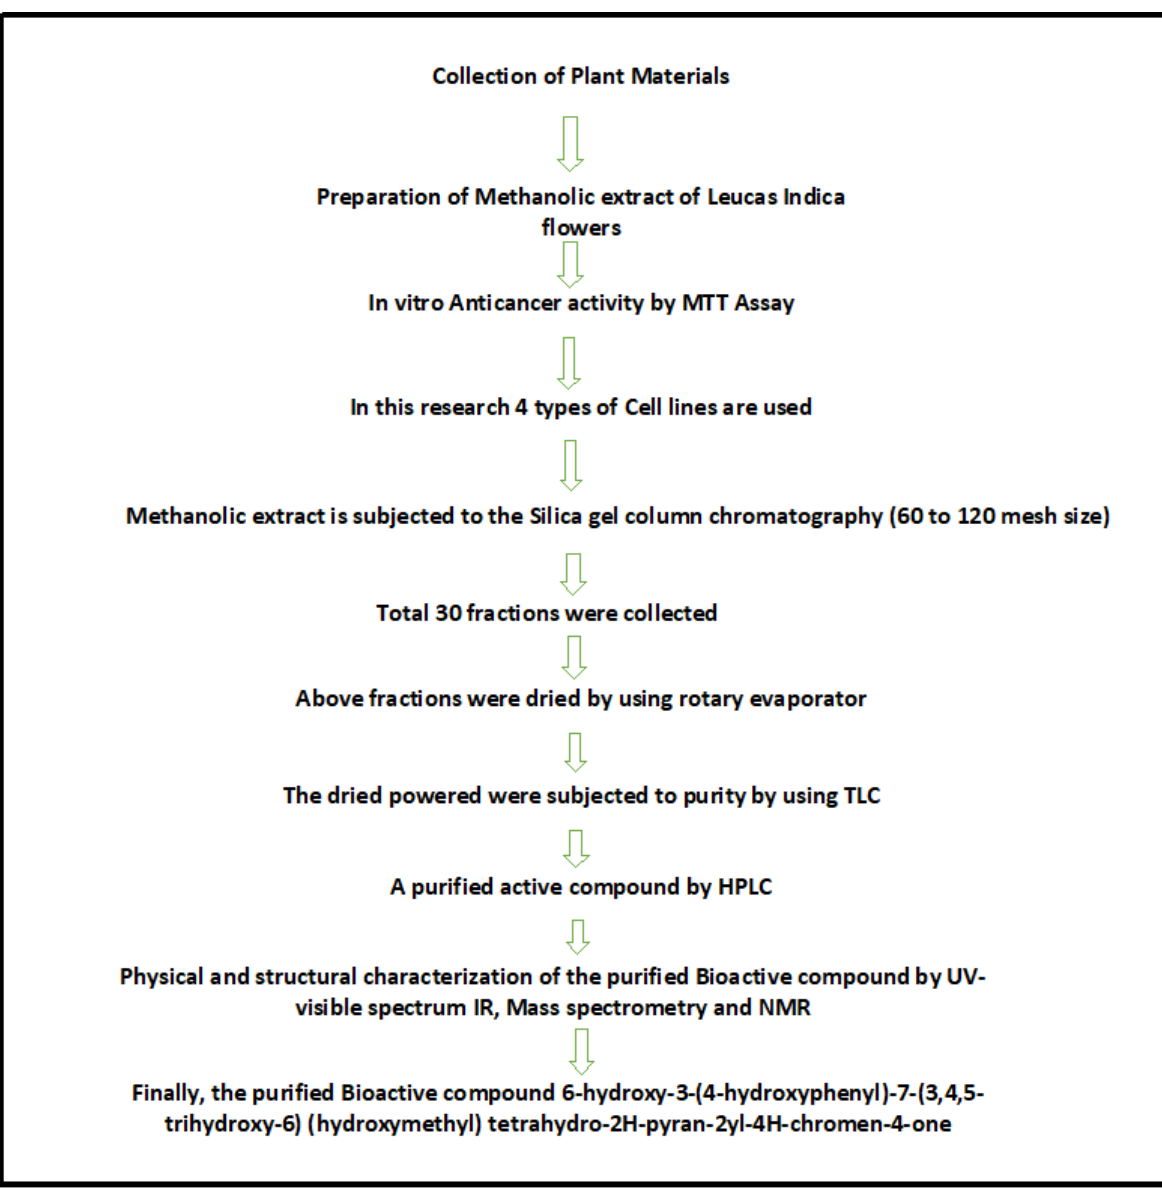
Figure 1. Schematic illustration of current research work.